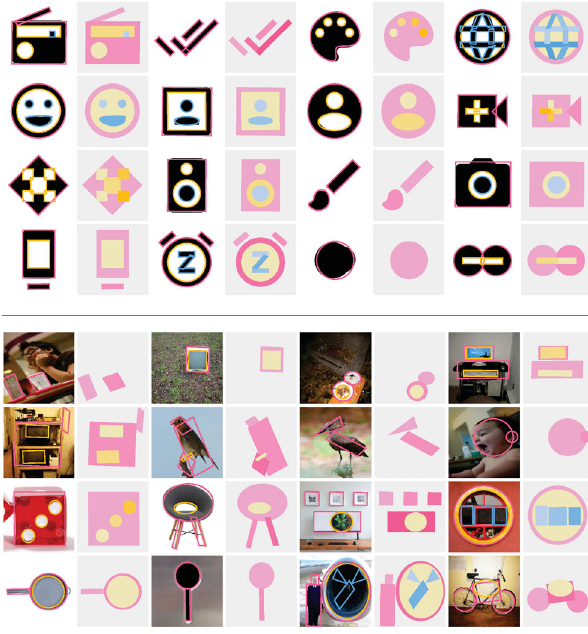
Fig. 6 Selected test results for our layered detection model. In each pair of columns, the left picture shows the original input image as well as the detection result while the right picture reconstructs the input image using the detection result (different instances of primitives within the same hierarchy vary slightly in color for clarity). More test results are available in Sections S3 and S4 in the